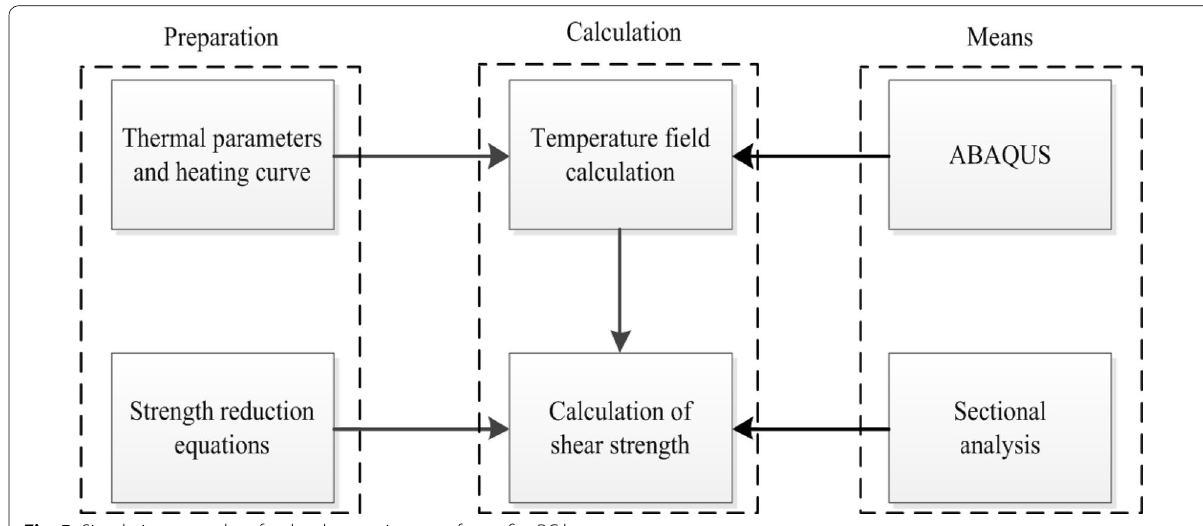
Fig. 5 Simulation procedure for the shear resistance of post‑fire RC